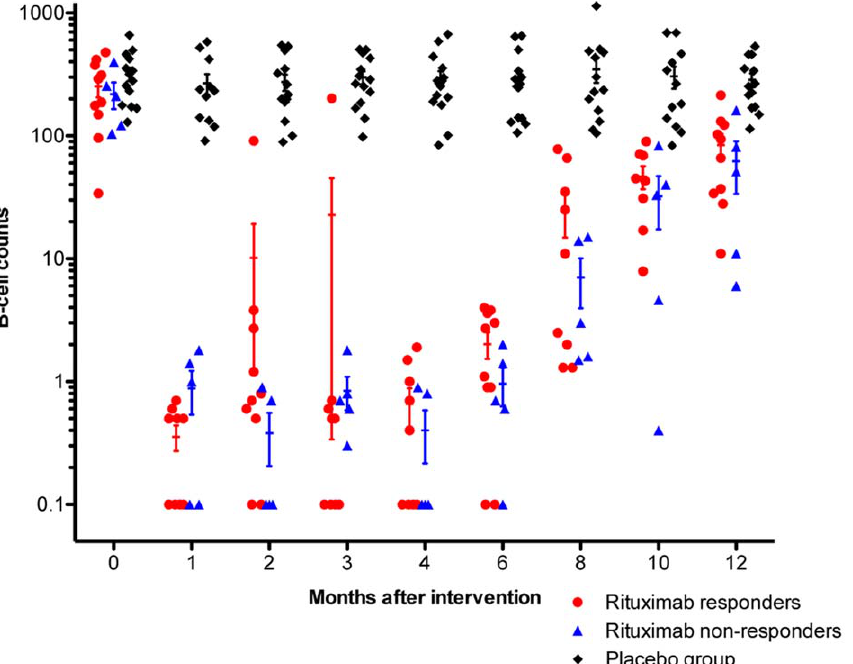
Figure 4. B-lymphocytes during follow-up. B-cell numbers from immunophenotyping of peripheral blood during follow-up are shown, for patients in the Placebo group (black, n=15), patients in the Rituximab group with significant response (red, n=10), and patients in the Rituximab group with no response (blue, n=5). The B-cell value zero was substituted by 0.1 (to be able to plot on the log scale). B-lymphocyte counts 6 10 6 /L (normal range 110–449). The error bars denote mean 6 SEM.